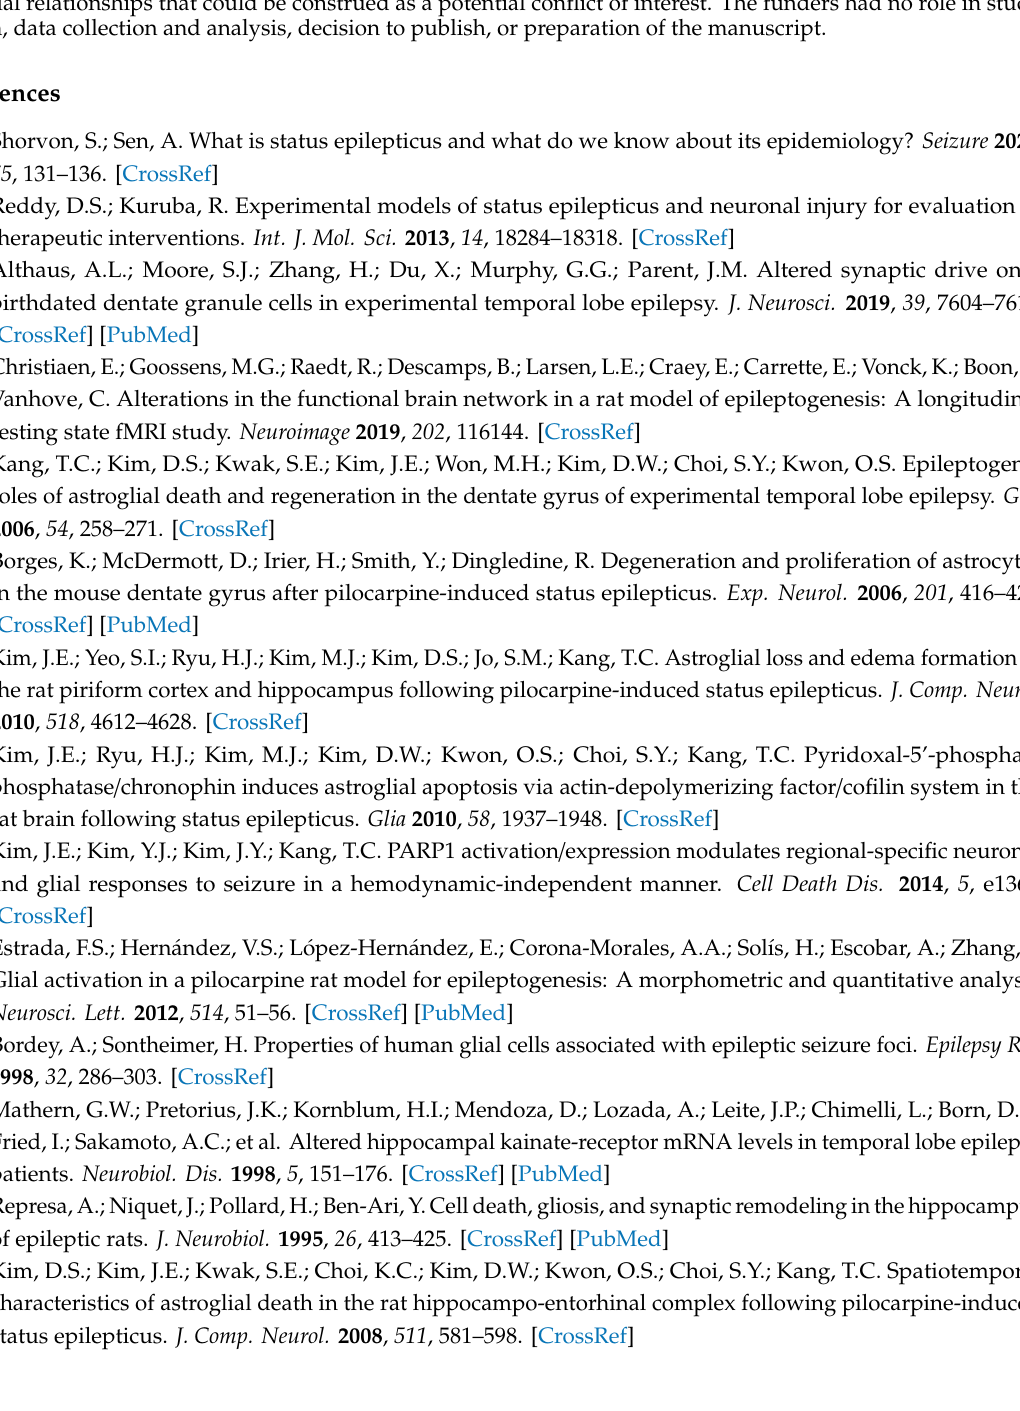
Figure S1: Full-gel images of Western blots in Figures 1A and 3A, Figure S2: Full-gel images of Western blots in Figure